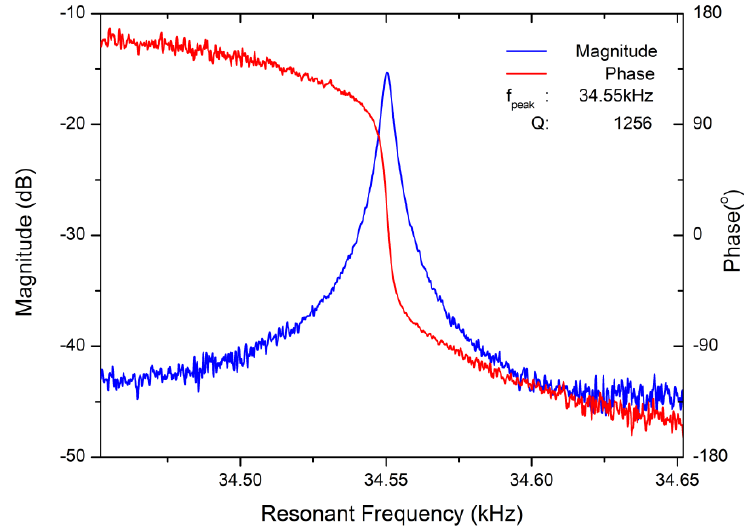
Figure 11. Resonance characteristics of the resonant pressure sensor at atmospheric pressure.